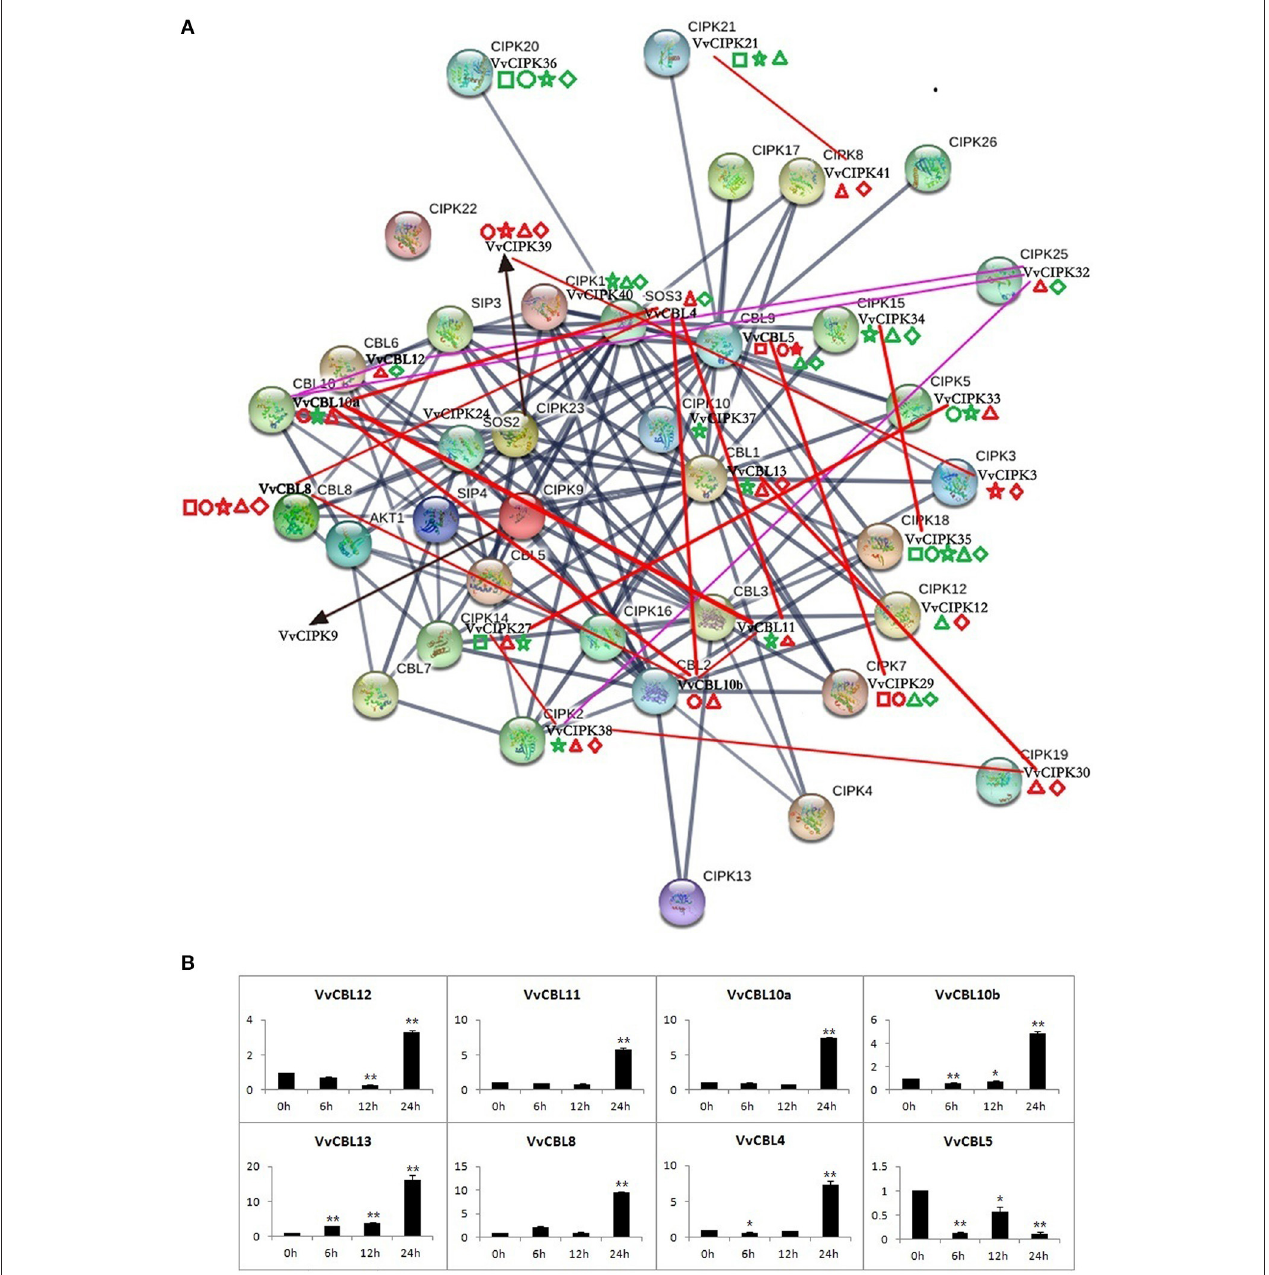
FIGURE 6 | The protein interaction analysis of CBLs and CIPKs in Arabidopsis and grapevine (A) , as well as expression profile of VvCBLs in response to low temperature stress (B) . The dark blue lines represent interaction of AtCBL and AtCIPK proteins. Purple and red lines represent the co-expression relationships between VvCBL and VvCIPK genes based on the microarray data and qRT-PCR data, respectively. The thicker lines denote the higher confidence. The square, circle, pentagram, triangle, and rhombus indicate the gene expression patterns in responding to salt, PEG, low potassium, cold, and heat stress, respectively. The red shape is three-fold changes up-regulated and green is